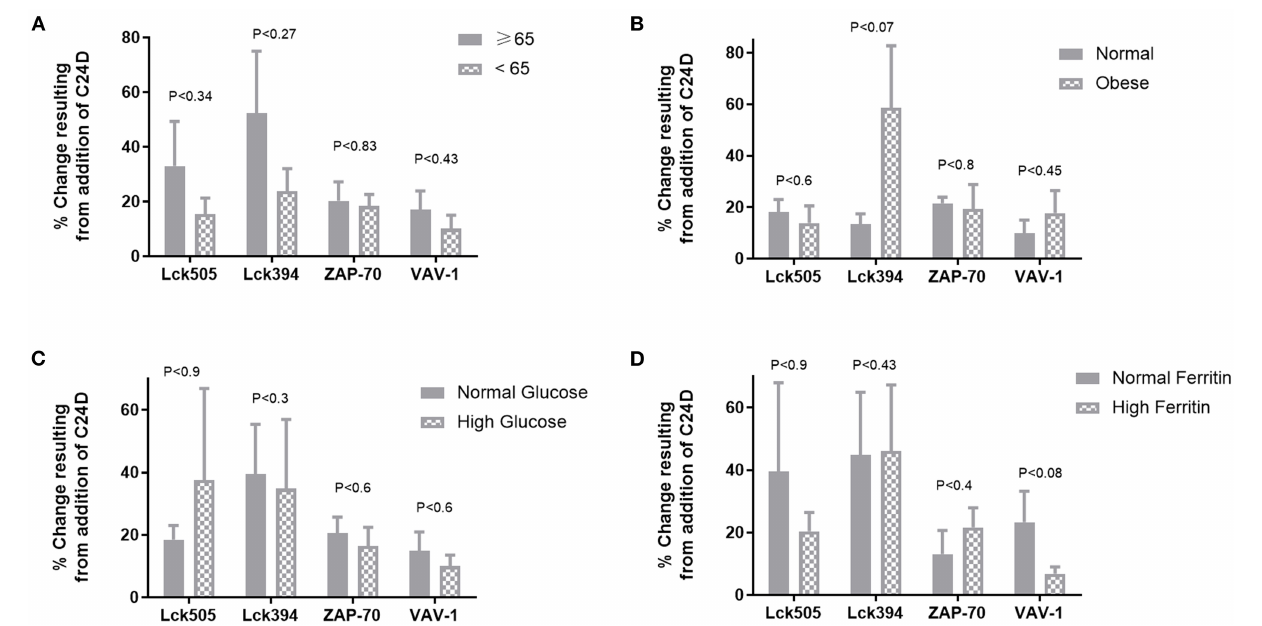
FIGURE 3 | Correlations between clinical characteristics and the protein phosphorylation pattern: no significant differences were found between age, weight, glucose levels or ferritin values and the change of phosphorylation in proteins, normalized to control without C24D. (A) Age, in two groups ≥ 65 vs. < 65 years of age, p < 5.7 × 10 − 5. (B) Weight, in two groups, normal weight: 66.4 ± 9.1 vs. obese: 109.3 ± 6.02, p < 0.00004 (C) Glucose, in two groups, normal glucose: 91.9 ± 0.02 vs. high glucose: 144.3 ± 54, P < 0.027 (D) Ferritin, in two groups, normal ferritin: 316 ± 145 vs. high ferritin: 712 ± 79, p <